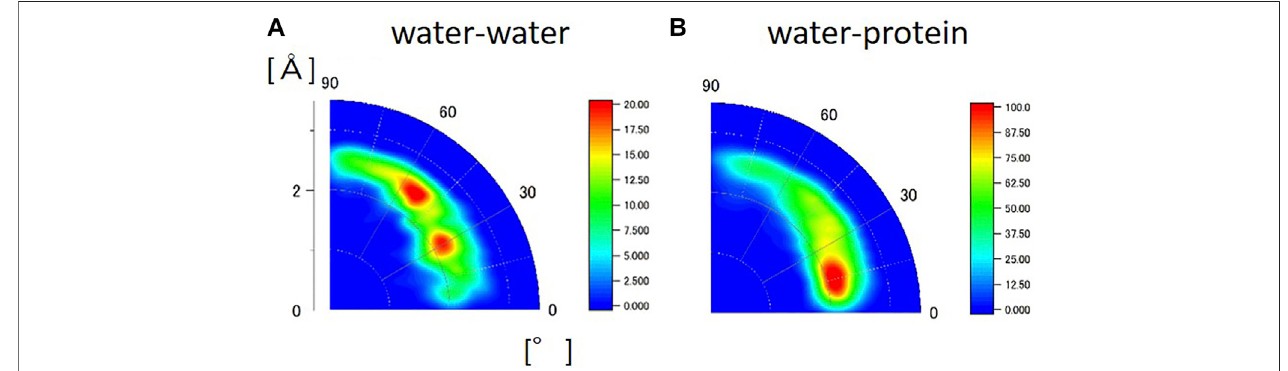
FIGURE 6 | Geometrical distribution of O-H ... O calculated from HHDB (A) between water and water and (B) water and protein from the HHDB. Neutron data above 2.0 (cid:2) A resolution are used for the analysis.